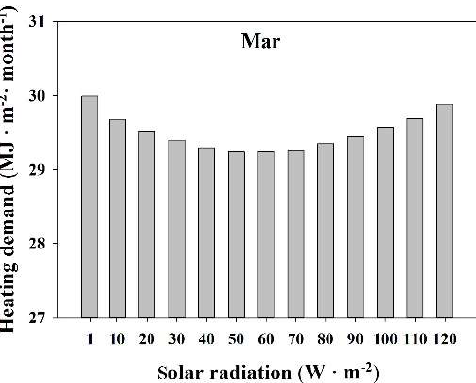
Figure 16. Monthly energy consumption of greenhouse with di ff erent solar radiation